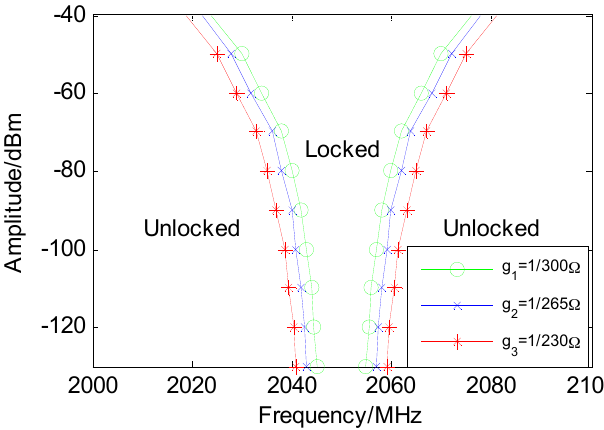
Figure 12. Relationship between the spectrum-sensing range of the system and the amplitude of the input signal intensity, or the conductivity, g ( I sc “ 220 µ A, I cc “ 300 µ